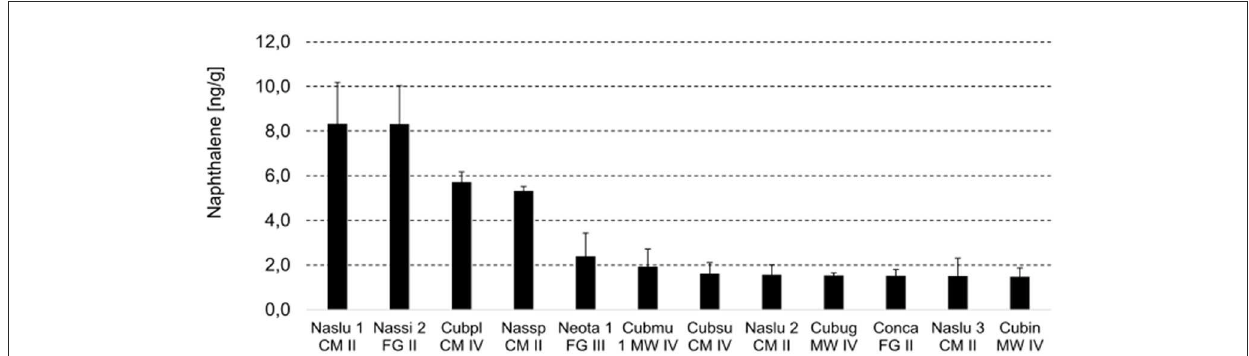
FIGURE2 Naphthalene analysis: results from targeted metabolite profiling. Naphthalene concentration is expressed in ng per gram of nest material. Naslu, Nasutitermes lujae ; Nassi, Nasutitermes similis ; Cubpl, Cubitermes planifrons ; Nassp, Nasutitermes sp.; Cubmu, Cubitermes muneris ; Cubsu, Cubitermes sulcifrons ; Cubug, Cubitermes aff. ugandensis ; Conca, Constrictotermes cavifrons ; Cubin, Cubitermes inclitus ; CM, Cameroon; FG, French Guiana; MW,